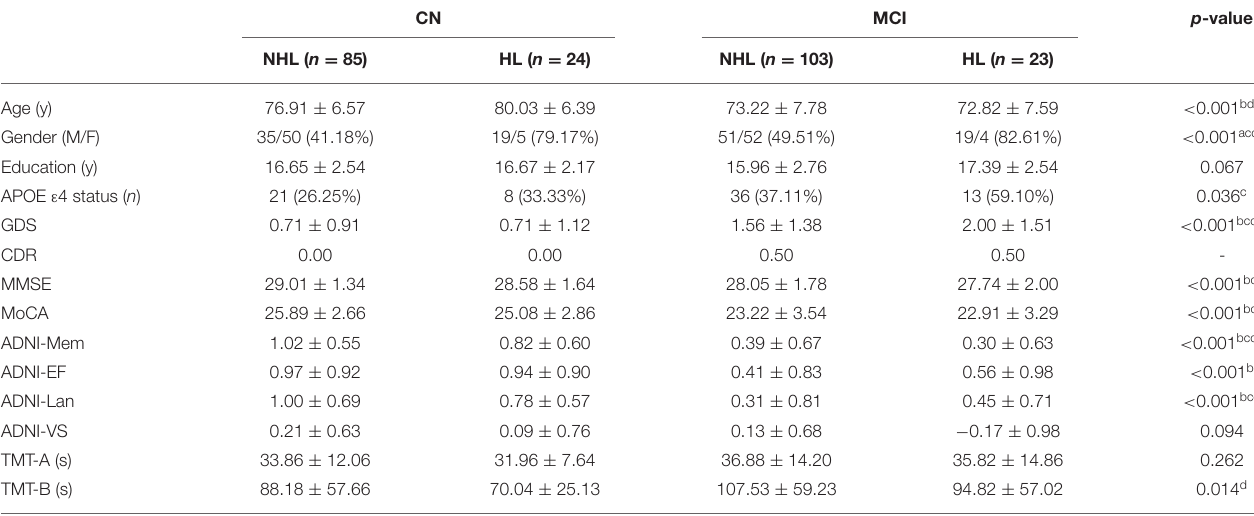
TABLE 1 | Demographic information and neuropsychological test results of the four